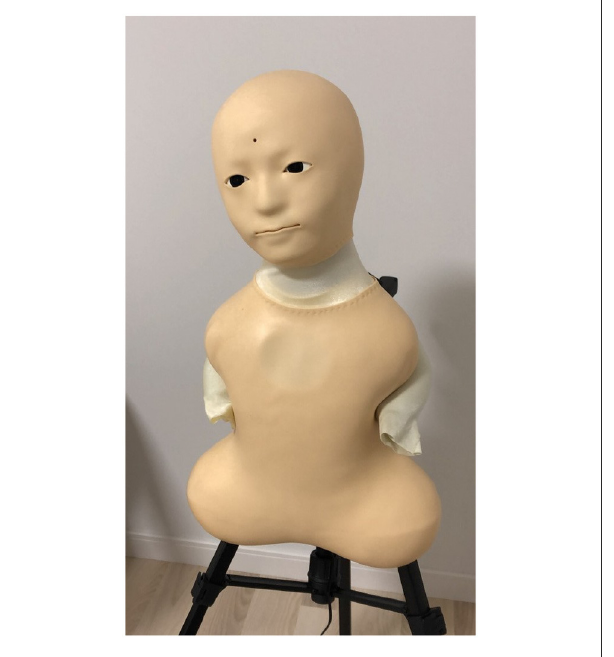
FIGURE2 The telenoid robot.